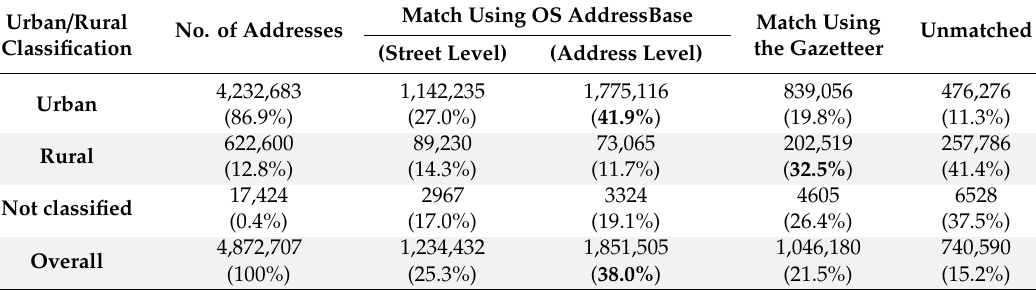
Table 3. Summary results of the overall match